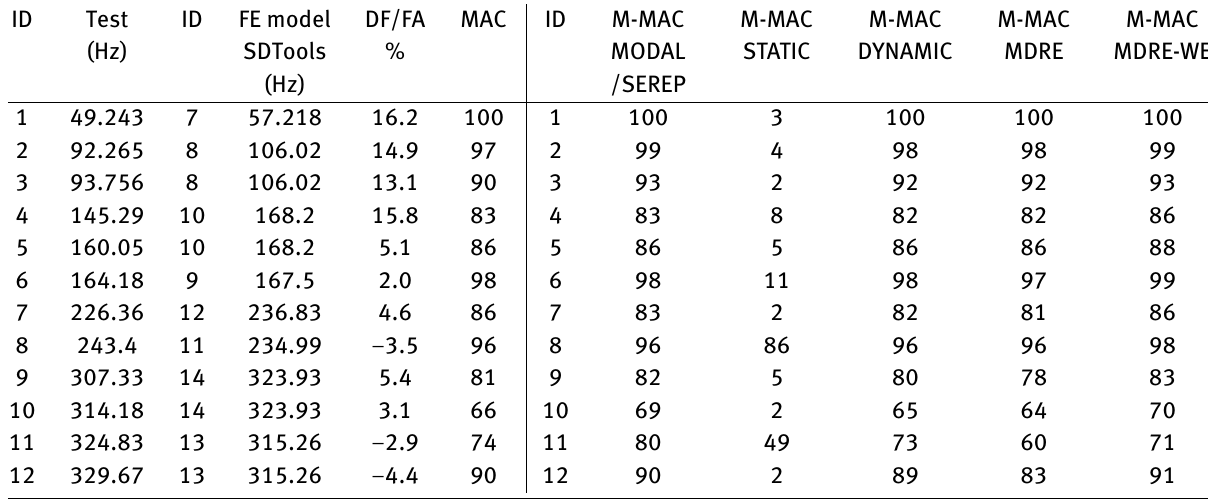
Table 5: Comparative MAC: Updated full model (SDTools) and M-MAC MSE results vs. experimental measurements.